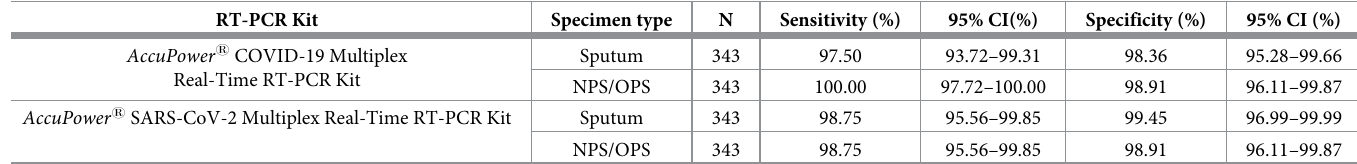
Table 4. Clinical sensitivity and specificity evaluation results for the AccuPower 1 kits in Sputum or NPS/OPS